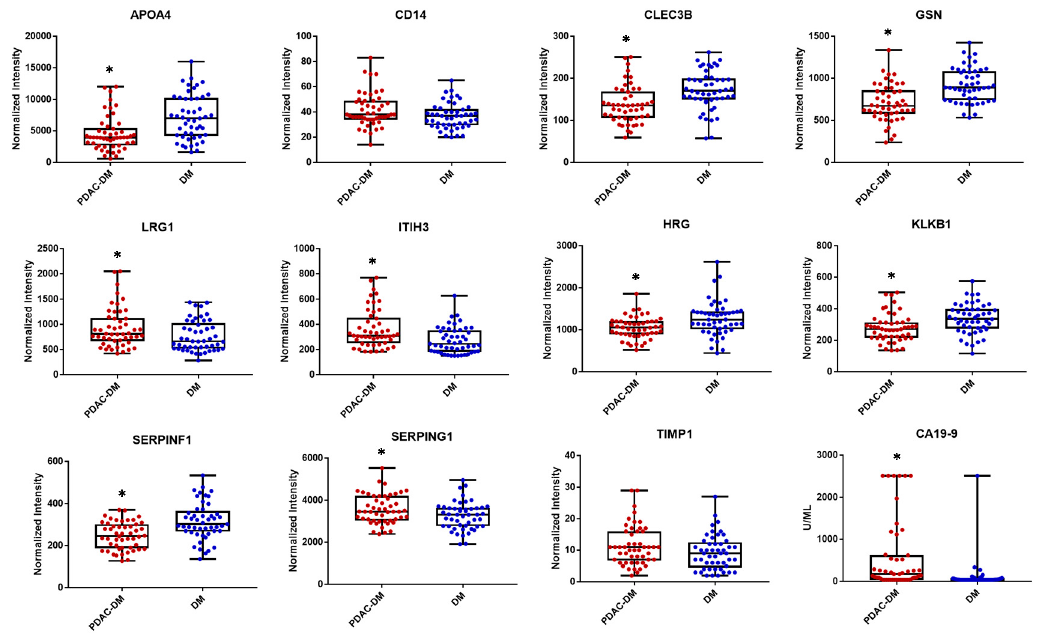
Figure 4. Measurements of the 11 protein candidates in the plasma samples of the testing cohort, which included 50 PDAC-DM and 49 DM controls; * p ≤ 0.05. Table 2. AUC of protein candidates in the testing cohort.